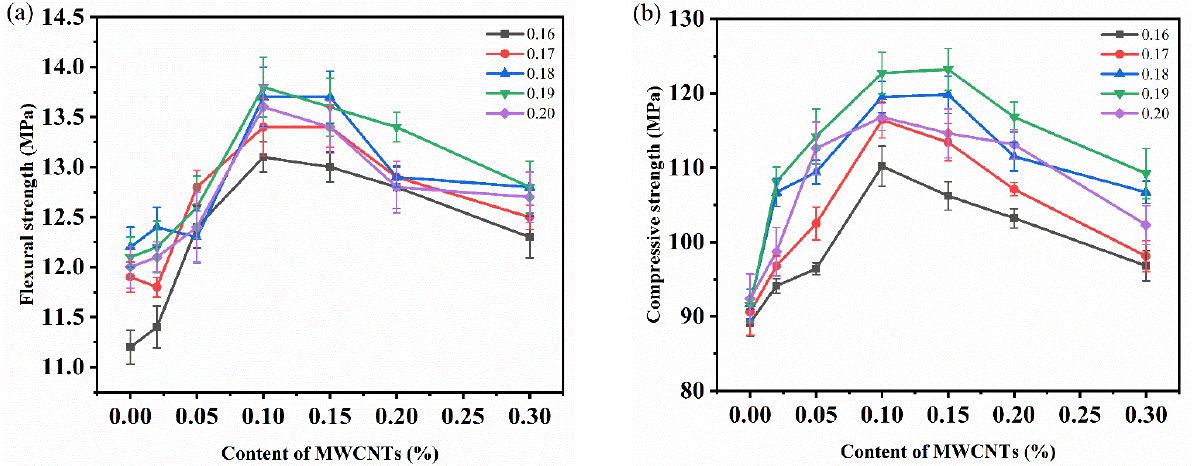
Figure 3. Mechanical properties of MWCNTs UHPC with different water binder ratios (0.16–0.20) and different MWCNTs contents (0–0.30%): ( a ) Flexural strength; ( b ) Compressive strength.